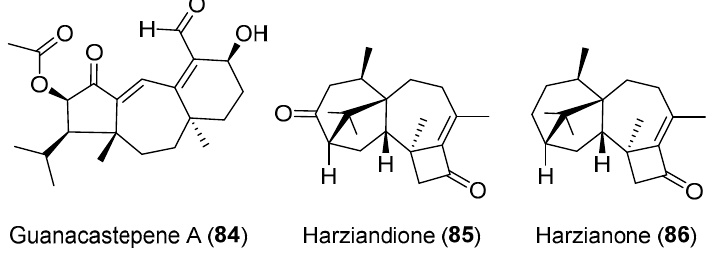
Figure 14. Structures of diterpenoids 84 – 86 .